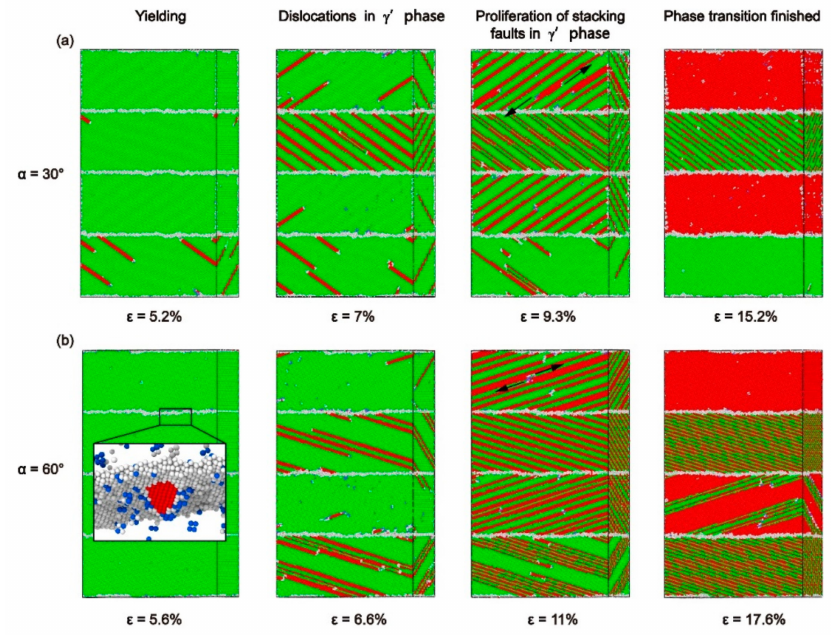
Figure 7. Plastic deformation processes of the model with di ff erent α : ( a ) α = 30 ◦ and ( b ) α = 60 ◦